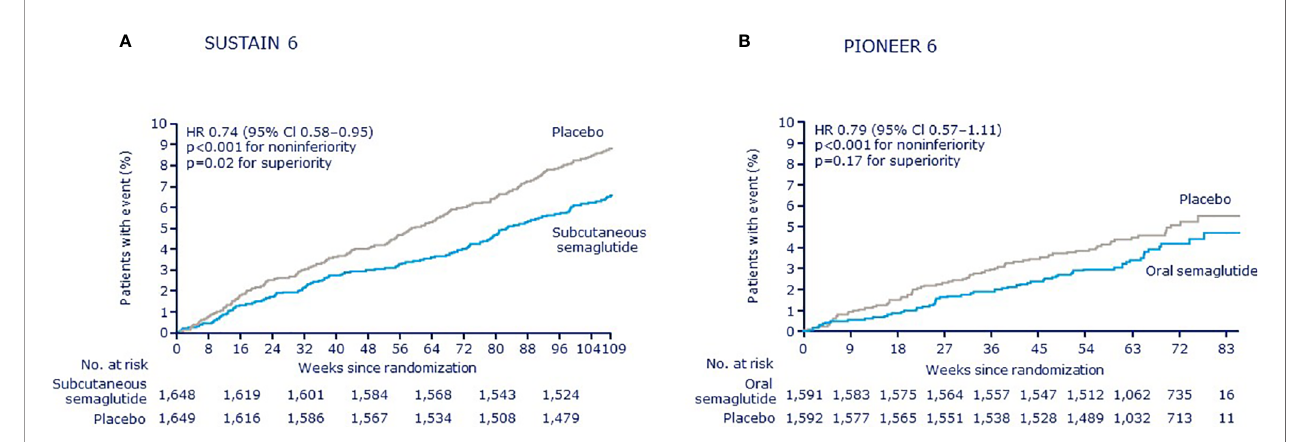
FIGURE 1 | Kaplan – Meier plots of the primary outcome (a composite of cardiovascular death, nonfatal myocardial infarction, or nonfatal stroke) in SUSTAIN 6 and PIONEER 6 (11). (A) SUSTAIN 6 (B) PIONEER 6; CI, con fi dence interval; HR, hazard ratio. (A) From Marso SP, et al. Semaglutide and cardiovascular outcomes in patients with type 2 diabetes. N Engl J Med (2016) 375:1834-44. Copyright © (2016) Massachusetts Medical Society. Reprinted with permission from Massachusetts Medical Society. (B) From Husain M, et al. Oral semaglutide and cardiovascular outcomes in patients with type 2 diabetes. N Engl J Med (2019)